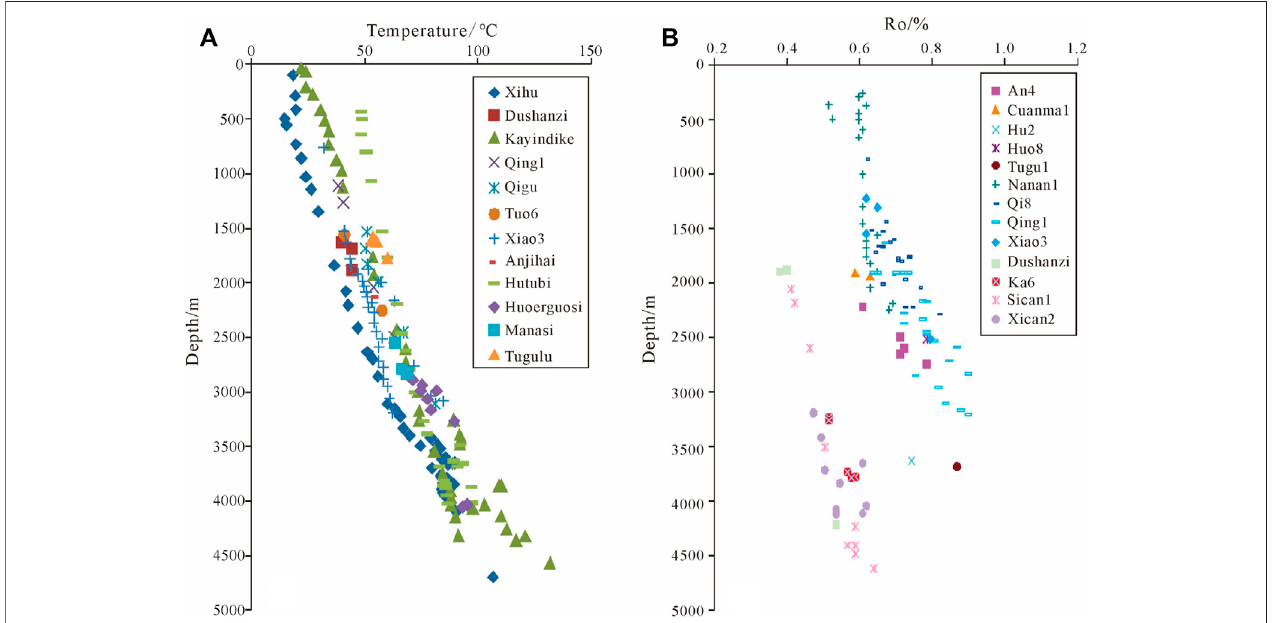
FIGURE 7 | Measured temperature and source rock Ro in different wells in the South Junggar Basin. (A) Measured temperature in different wells and structures in the south Junggar Basin. (B) Measured source rock Ro in different wells and structures in the south Junggar Basin.